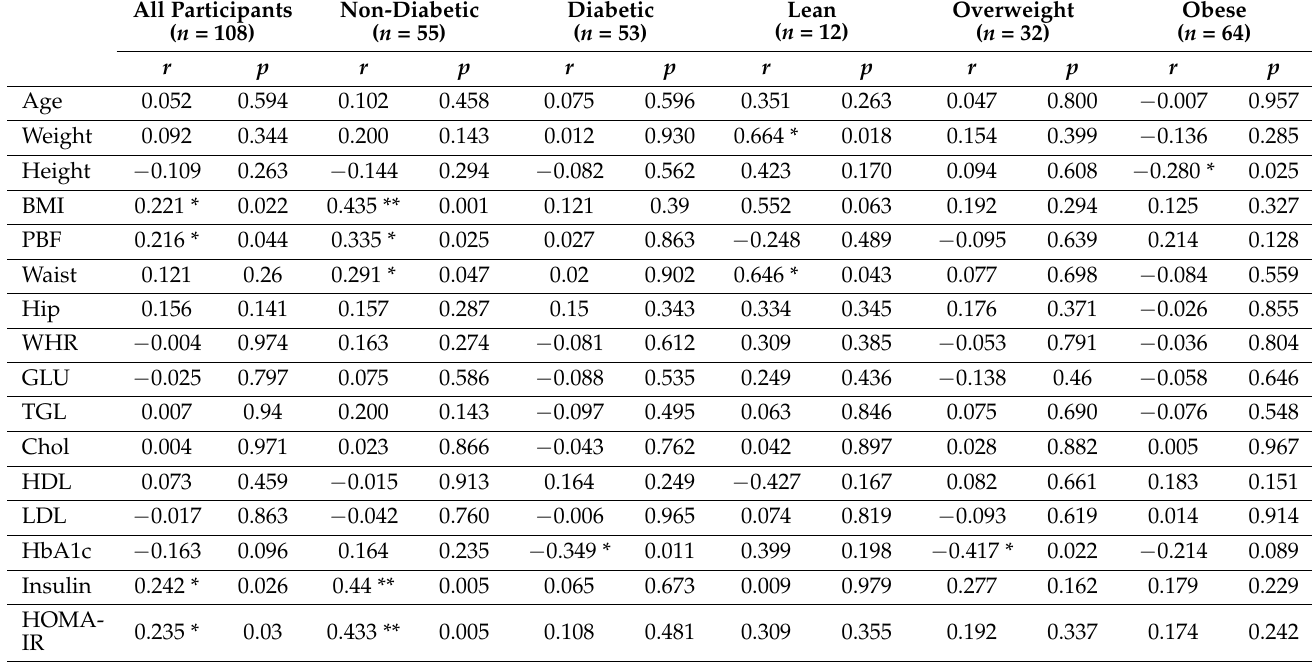
Table 3. Correlation of SRA1 expression level with various clinical and biochemical